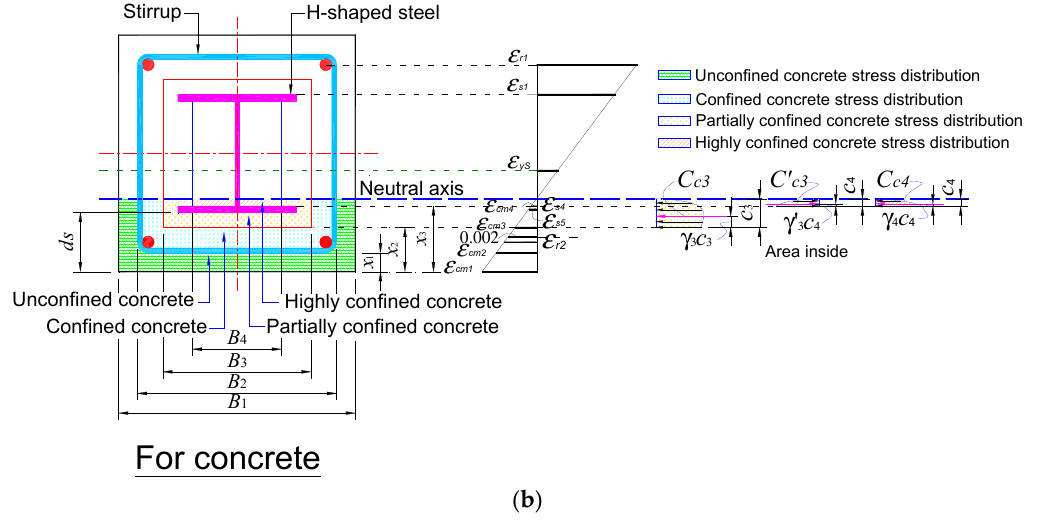
Figure 1. Four simplified zones with concrete stress–strain profiles. ( a ) Concrete confined by stirrups and a steel section (parabolic arching formed by the longitudinal bars and structural steel section [10]); ( b ) strains, stresses, and corresponding force components at the maximum limit state.